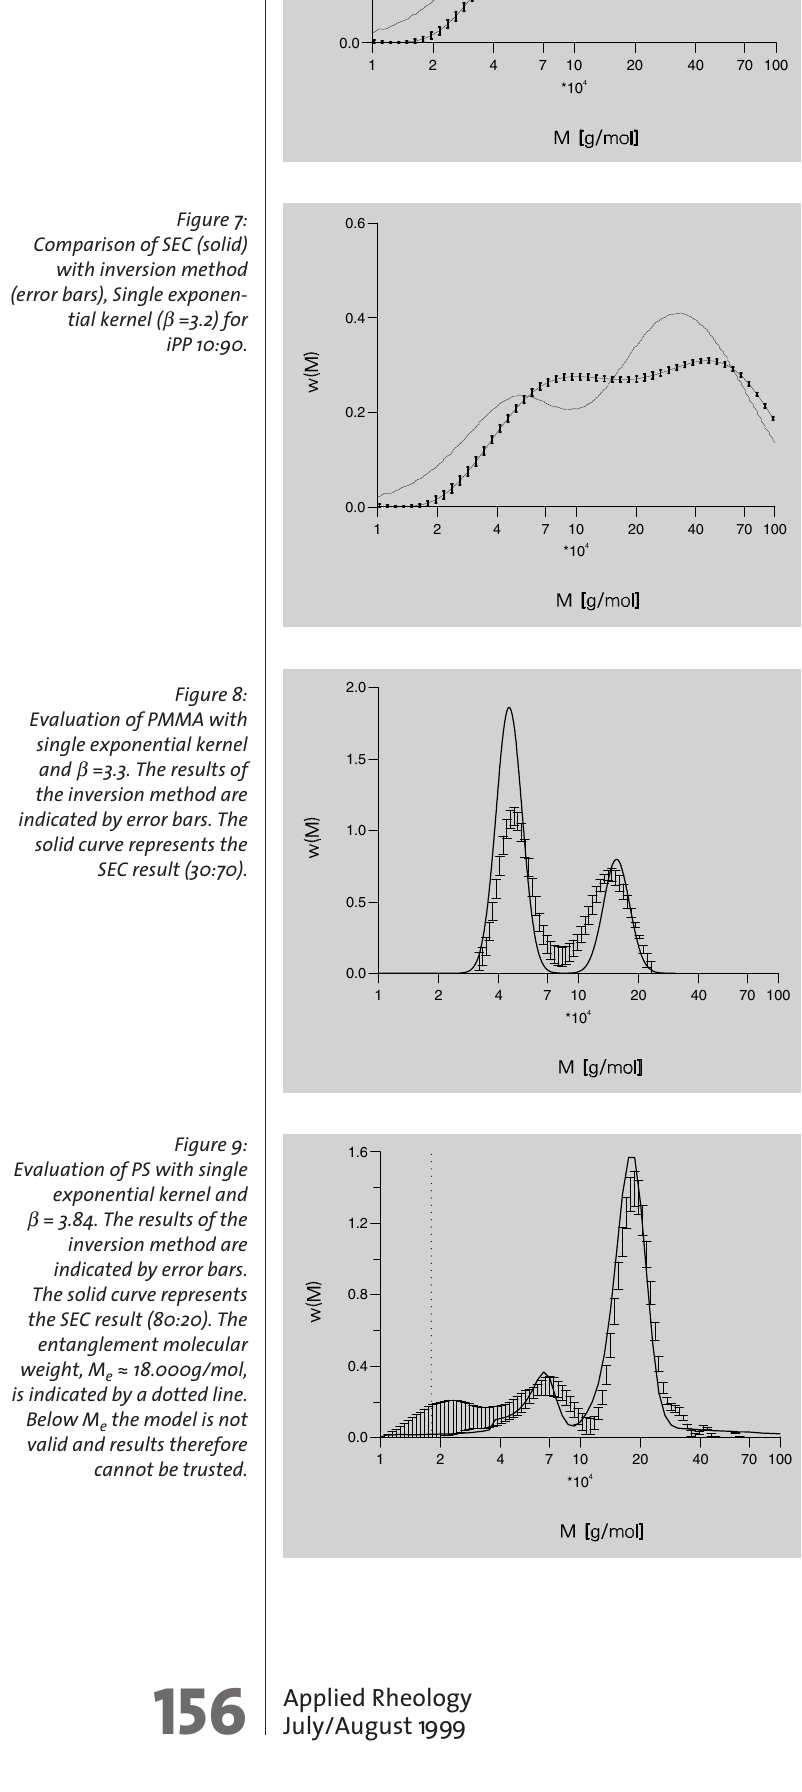
Figure 7: Comparison of SEC (solid) with inversion method (error bars), Single exponen- tial kernel ( β =3.2) for iPP 10:90.